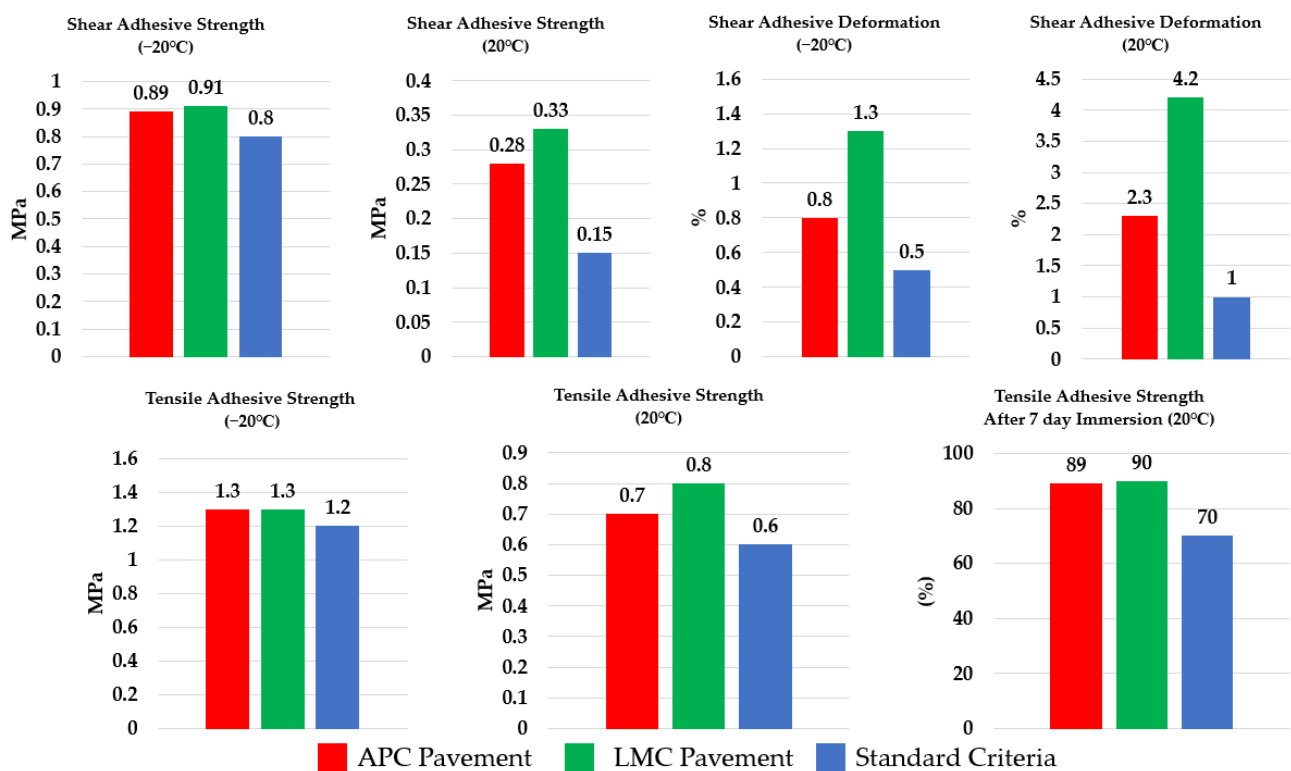
Figure 9. Individual comparison of physical property evaluation results of waterproofing sheets in APC and LMC pavement layers.